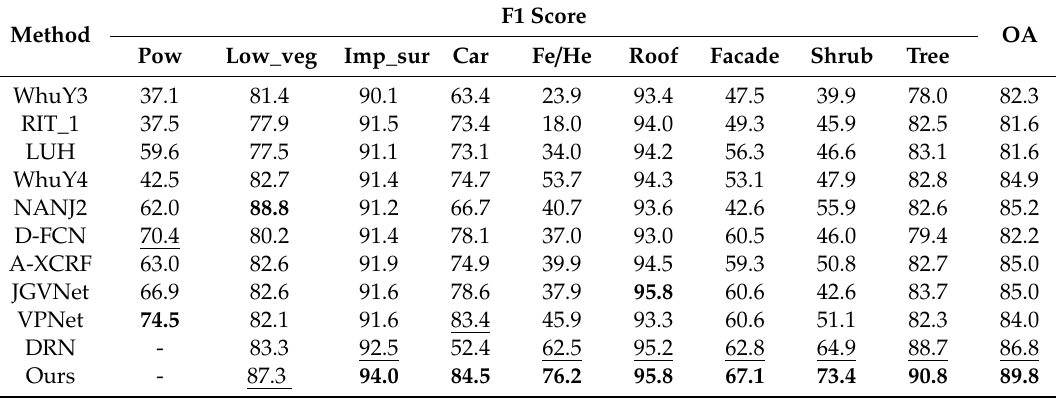
Table 3. F1 scores of each category and overall accuracy (OA) of different classification methods. Bold numbers show the highest values. The underlined numbers are the second-best values for each evaluation metric (%).